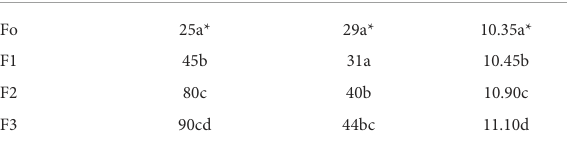
TABLE 2 Wet weight, dry weight, root length of seedling of Bali red rice. Treatment Root length (mm) Wet weight (g) Dry weight